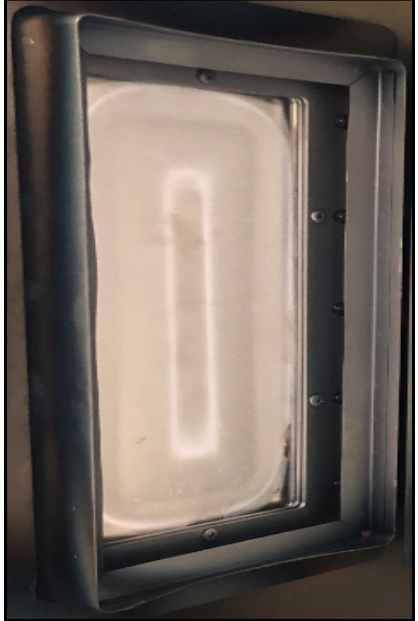
Figure 2 . The silver target used for sputtering deposition.